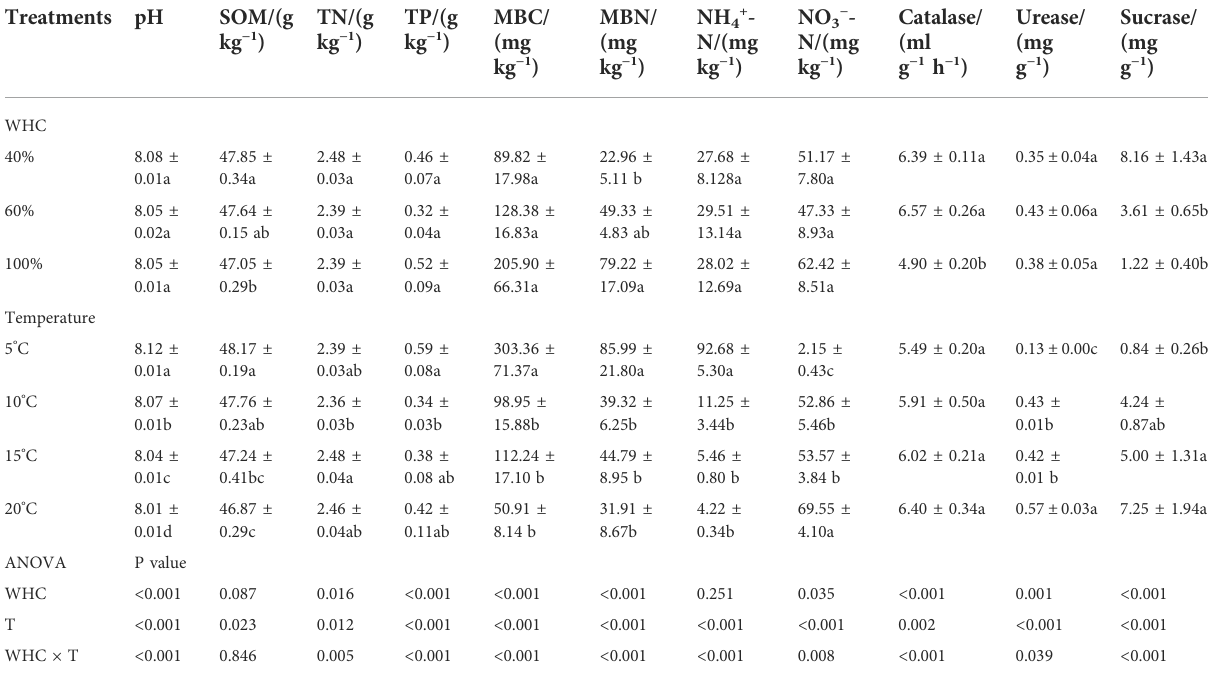
TABLE 3 Soil properties after 30 days of incubation.